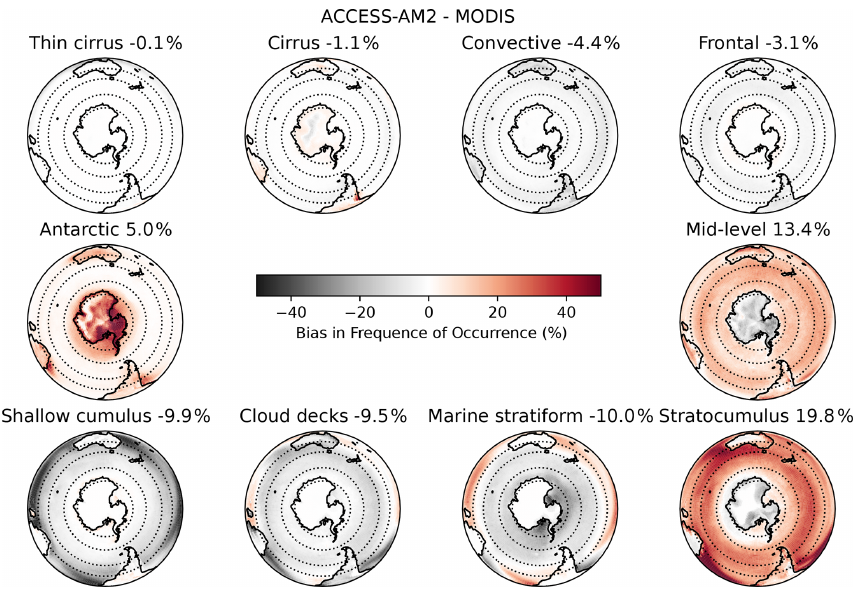
Figure 4. Spatial maps of the difference in the relative frequency of occurrence for ACCESS-AM2 – MODIS for each cloud cluster. The dashed lines represent the boundaries of the mid-latitude, sub-polar and polar regions as defined in Sect. 3. The numbers in each title represent the mean frequency of occurrence for each cloud regime (in time and space) over the SO